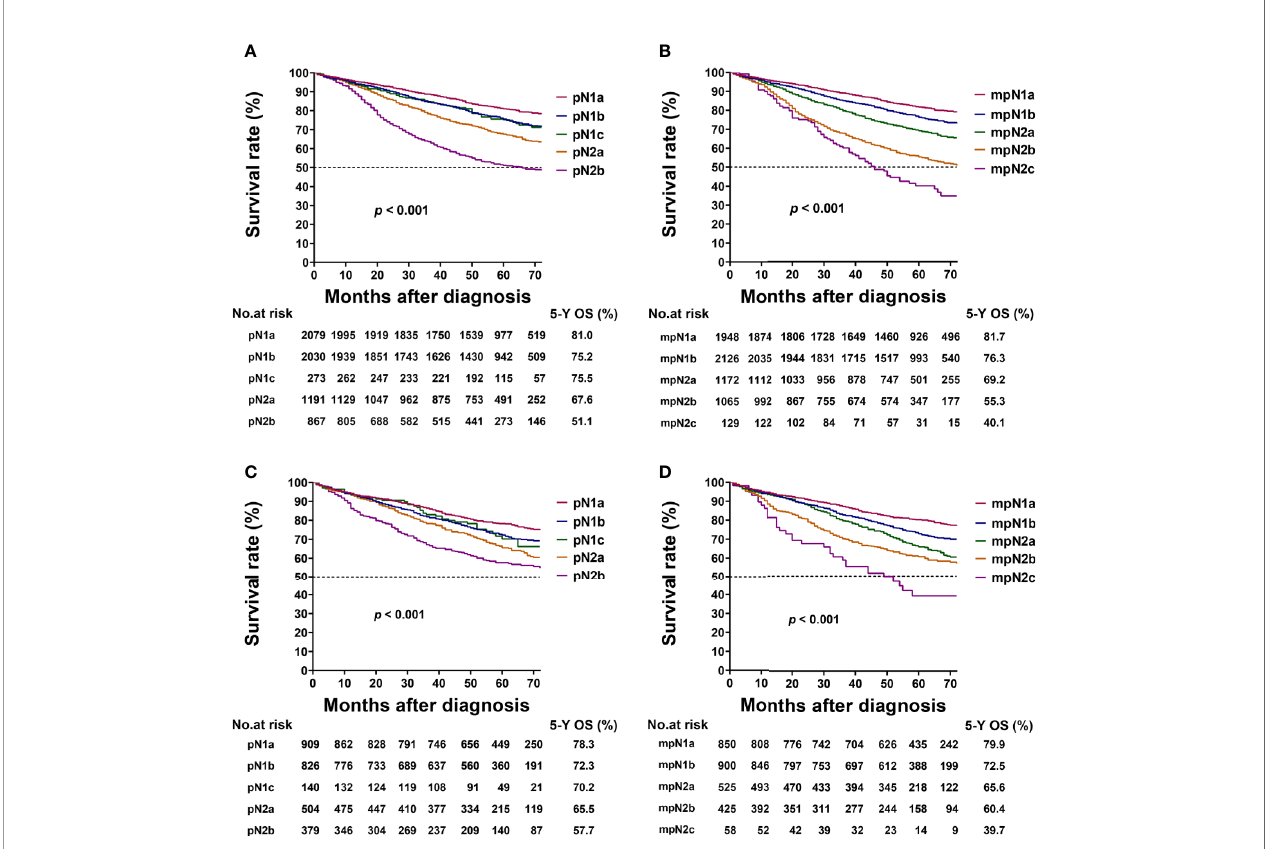
FIGURE 4 | Kaplan – Meier survival curves for 5-year overall survival (OS) based on the pathological N (pN) and modi fi ed pN (mpN) stages. Kaplan – Meier survival curves based on (A) pN stage in training cohort; (B) mpN stage in training cohort; (C) pN stage in validation cohort; and (D) mpN stage in validation cohort.